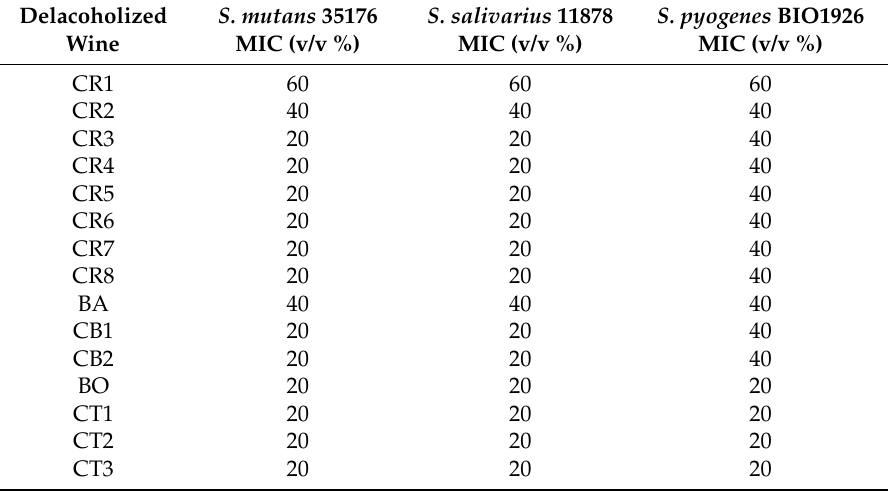
Table 5. Minimal inhibitory concentration (MIC) of each type of dealcoholized wine against two oral Streptococci and S. pyogenes . Concentration necessary to inhibit 100% of the microbial growth in vitro , expressed in v/v %